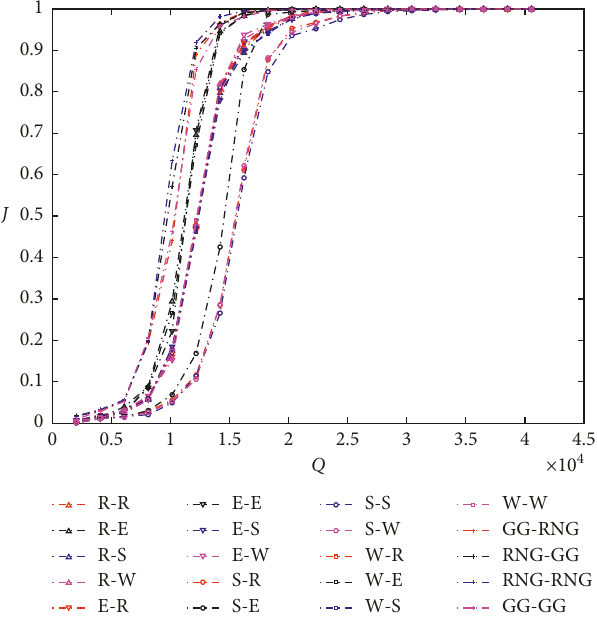
Figure 10: Completely coupled multilayer network performance as the total traffic flow